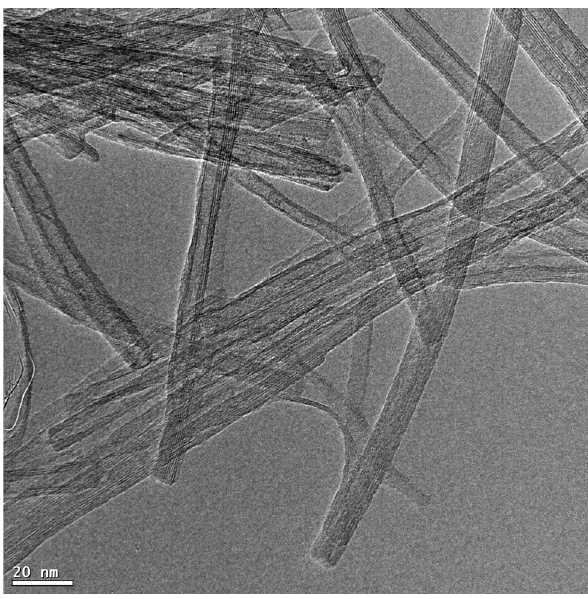
Figure 1: TEM micrograph of the as - synthesized titanate nanotubes.